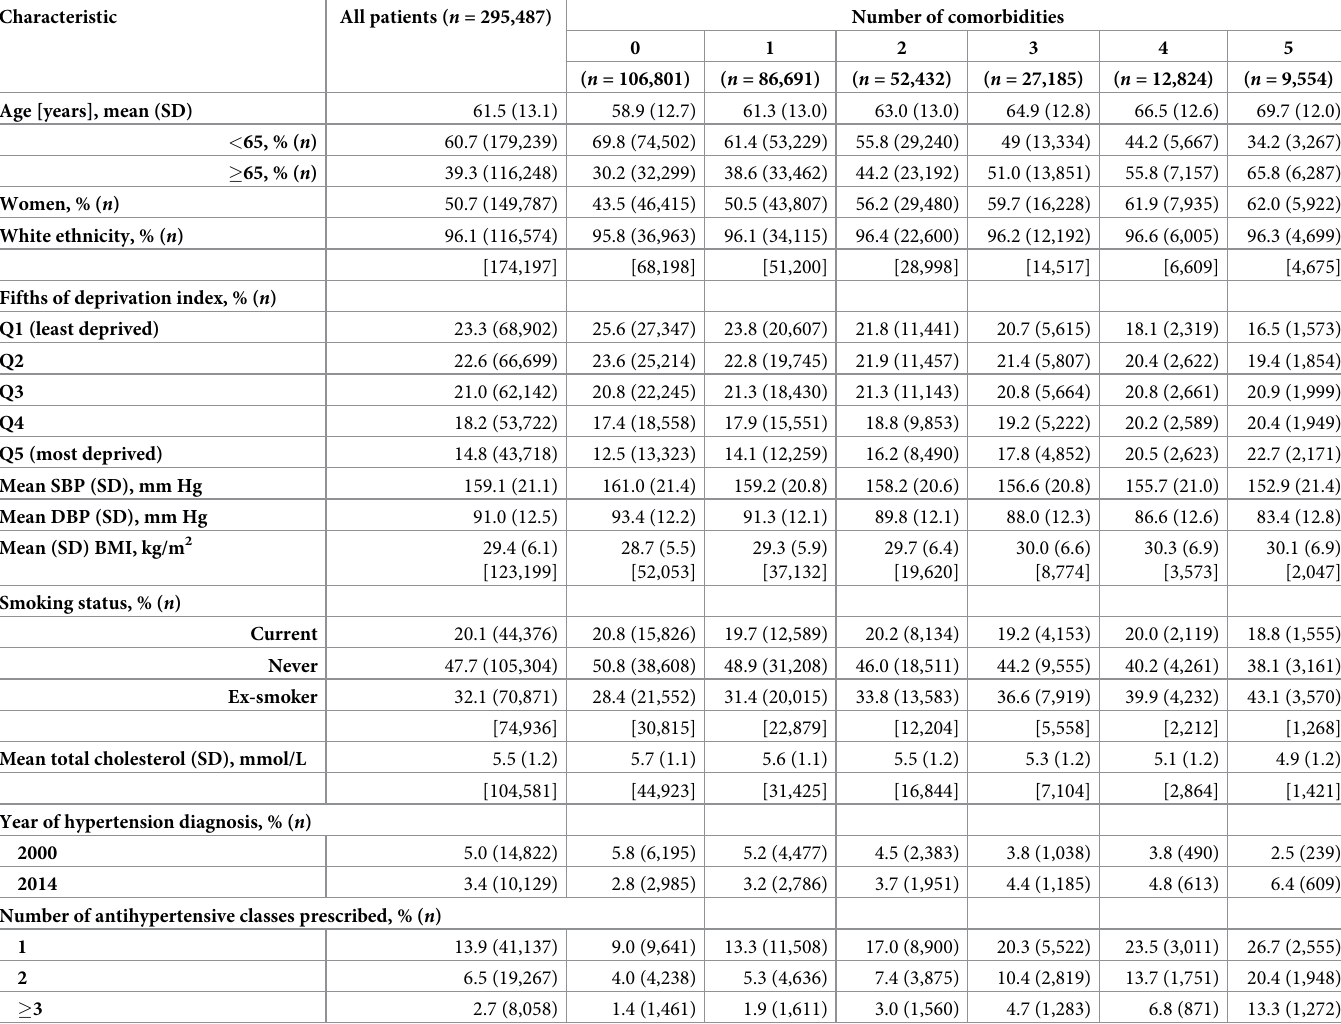
Table 1. Baseline characteristics of incident hypertensive patients between 2000 and 2014 in the UK, by number of comorbidities. Characteristic All patients ( n =